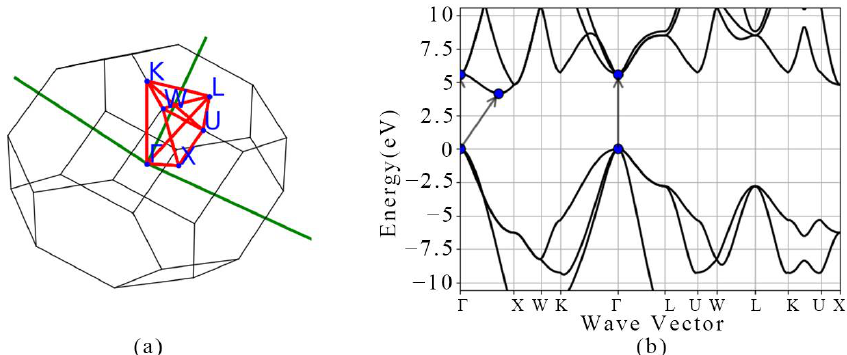
Figure 3. The energy band diagram of diamond: ( a ) the first Brillouin zone of diamond and the K-point path; ( b ) the energy band diagram of diamond.